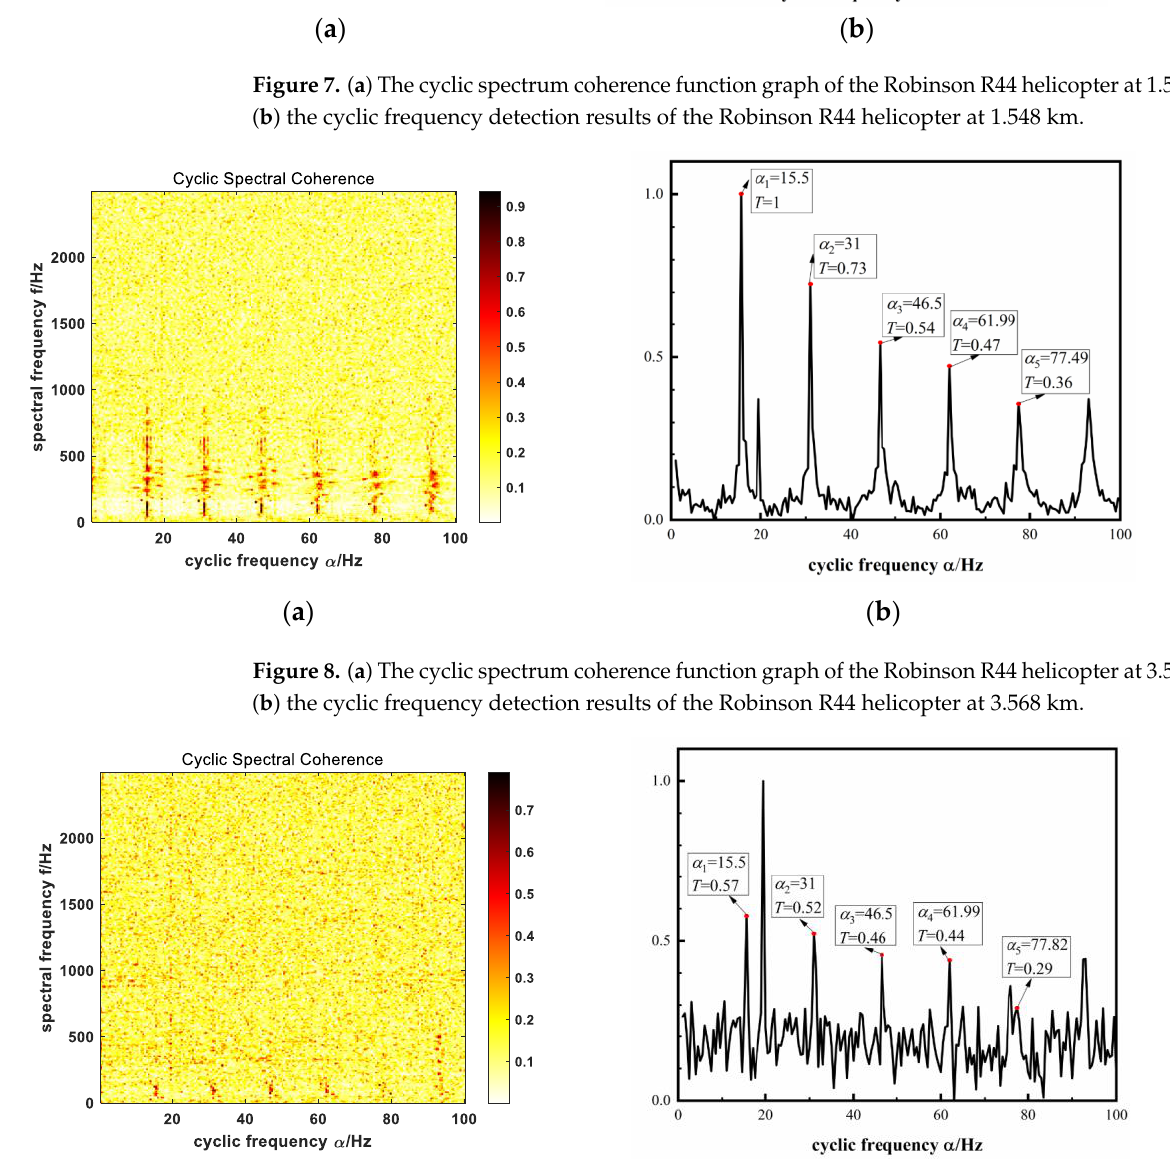
( b ) Figure 10. ( a ) The cyclic spectrum coherence function graph of the Robinson R44 helicopter at 17.75 km; ( b ) the cyclic frequency detection results of the Robinson R44 helicopter at 17.75 km.